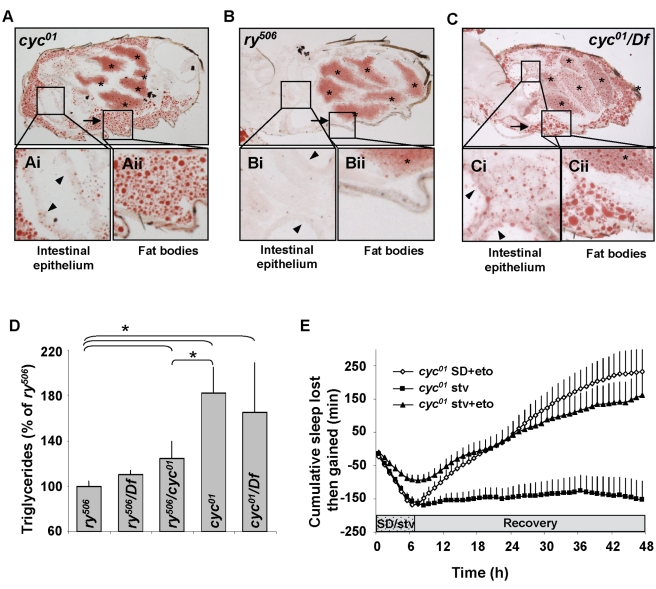

cyc01 flies have increased adiposity.(A) Representative Oil Red O staining, which stains lipids red, reveals high levels of fat stores in the abdomen of female cyc01 flies. Boxed areas (Ai and Aii) are presented at higher magnification. * denotes developing eggs, and arrowheads are placed in the lumen of the gut and point to gut epithelial cells. Arrows point to the location of the fat bodies which abut the cuticle (9 flies were examined). (B) Representative section of ry506 abdomen, the background control for cyc01. ry506 have little accumulation of lipid droplets in the abdomen in similar areas to (A) as revealed by Oil Red O staining. Boxed areas (Bi and Bii) are presented at higher magnification (9 flies were examined). (C) Representative section of Oil Red O stained cyc01/Df abdomen reveals high levels of fat stores. (Ci and Cii) are presented at higher magnification (9 flies were examined). (D) Organismal triglyceride (TG) levels are elevated in cyc01, cyc01/Df, and cyc01/ry506flies compared to ry506 controls; one-way ANOVA for Genotype F[4,38]  = 3.2; *p<.05 modified Bonferroni Test; n≥7 groups/condition, a group was comprised of 10 flies. (E) An elevated homeostatic response is observed in cyc01 mutants that were starved for 7 h (n = 45) on 1% agar containing 25 µM etomoxir. No further increase in homeostasis is found in cyc01 sleep deprived for 7 h on food containing 25 µM etomoxir (n = 72); compare with Figure 1A. Siblings starved in the absence of etomoxir are shown for comparison (n = 92); all experiments were conducted in parallel.